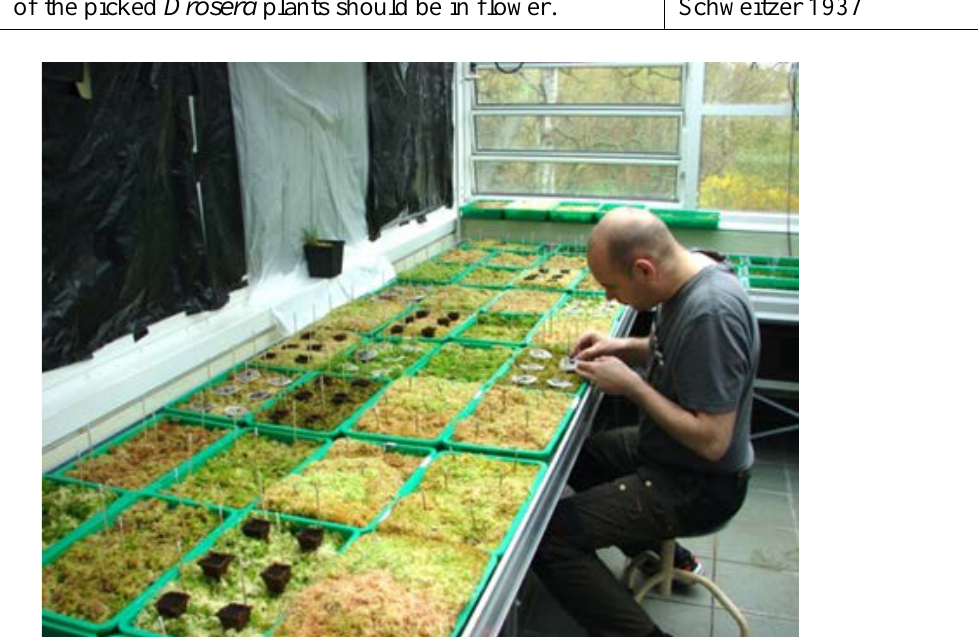
Figure A1. Installation of the greenhouse experiment in the Botanical Garden of Greifswald University in 2014. Photo: Balázs